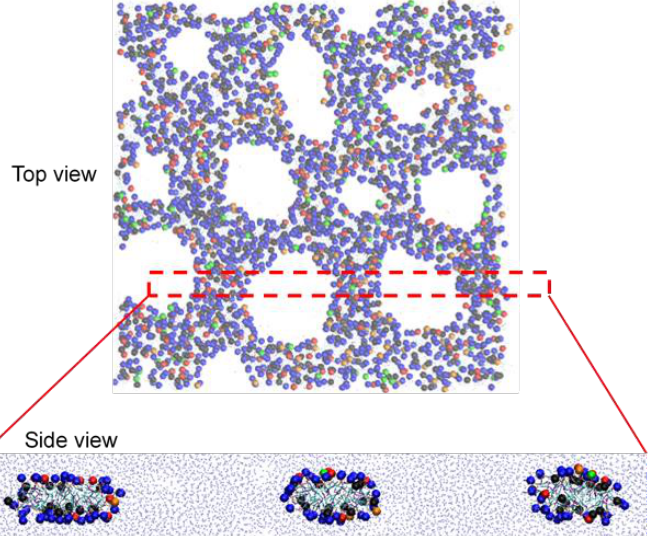
Figure 15. Top and side views at the end of simulation. Phosphate beads of DSPC, DSPE-PEG, DOPE, MSPC, and hydroxyl beads of cholesterol are represented as thick dots colored in red, orange, blue, green, and black, respectively.